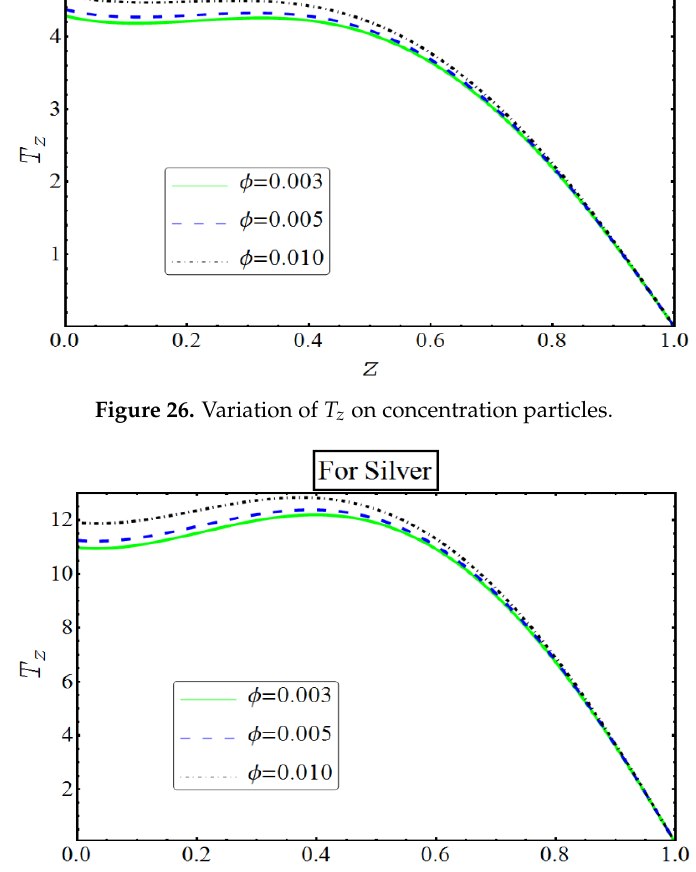
Figure 27. Variation of 𝑇 𝑧 on concentration particles.